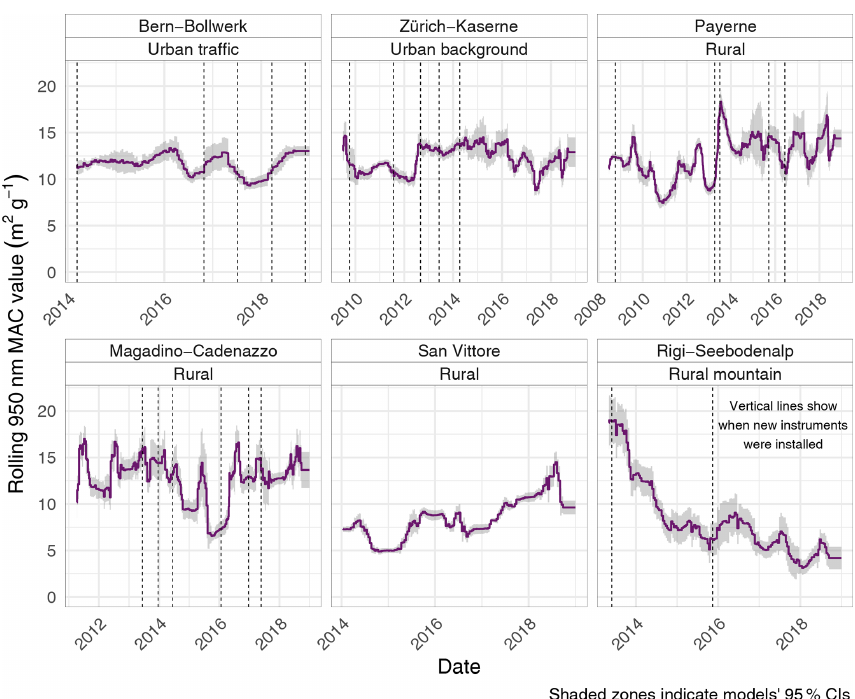
Figure 3. Mass absorption cross-section (MAC) coefficients for 950nm for different monitoring sites as calculated by rolling simple linear regression models with windows of 180d (alignment of the window was the centre of the period). CI: confidence interval.